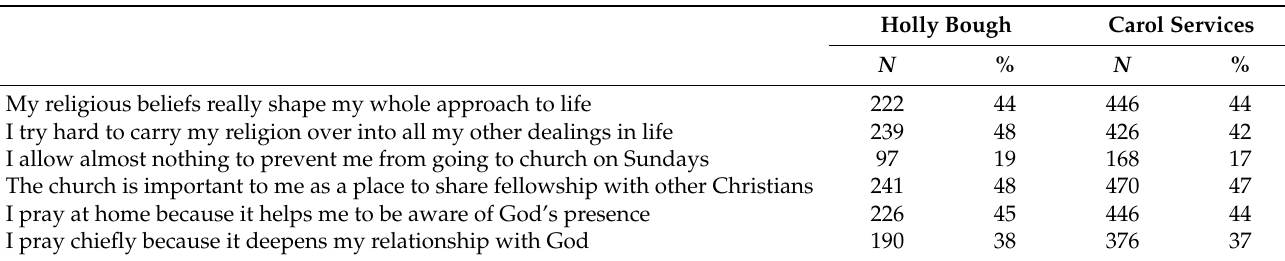
Table 13. Intrinsic religious orientation.